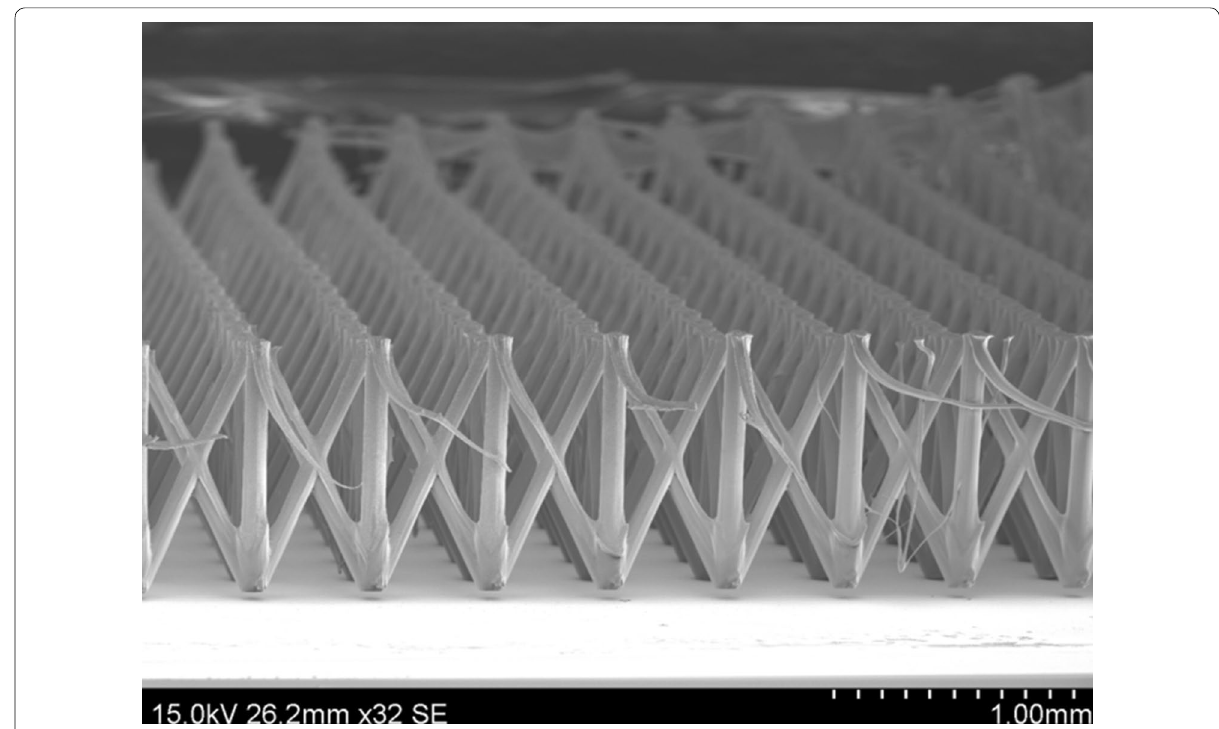
Fig. 8 Diamond-shaped, 1500-µm-long, tower array with potential use of a microfilter